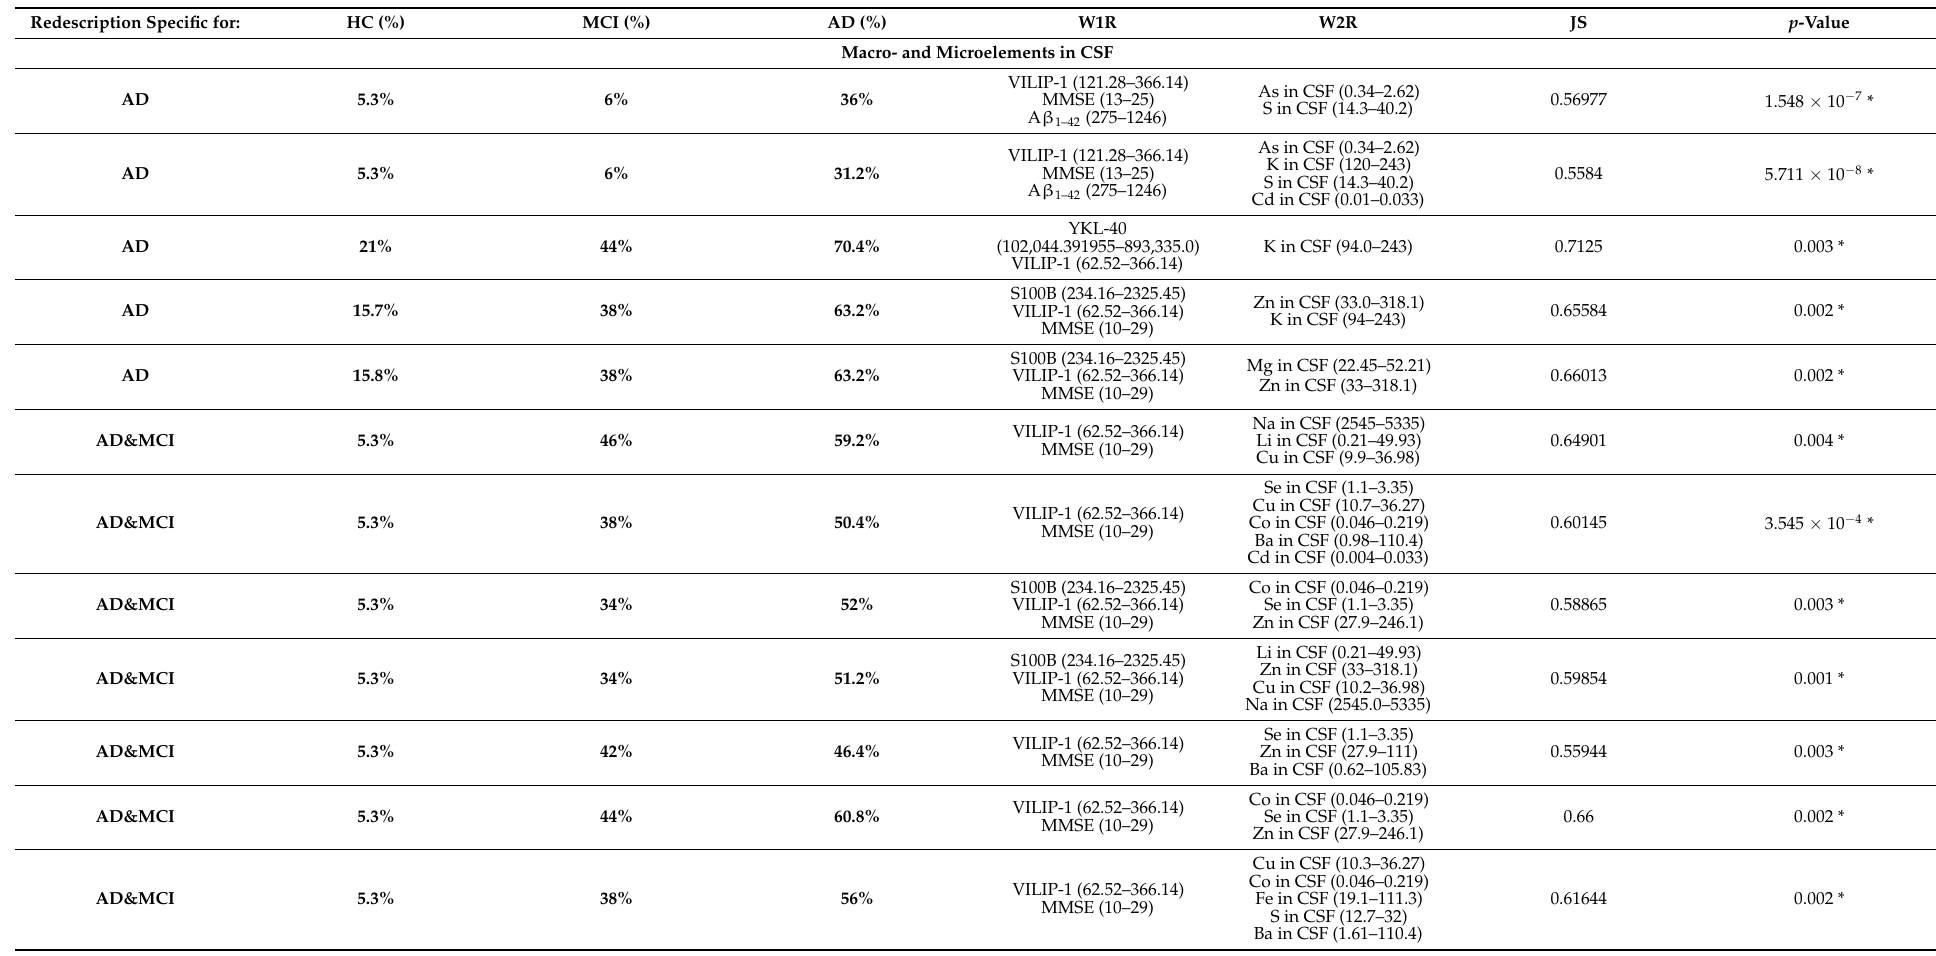
Table 6. Most significant redescriptions given by the combination of CSF AD biomarkers (first view—W1) and macro- and microelements measured in CSF (second